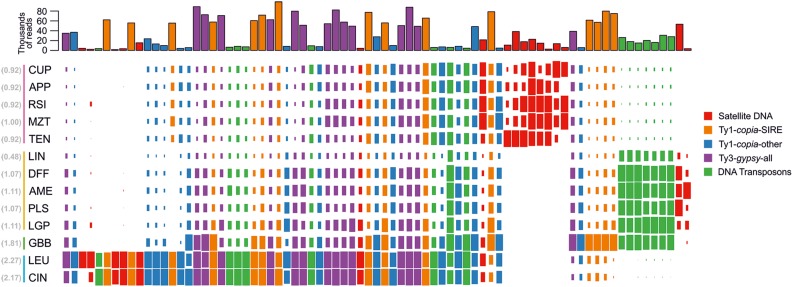
Normalized genome representation of the top clusters of five major repeat groups found in the genomes of species analyzed in the comparative analysis. Each of the four major repeat types (Ty1-copia-SIRE; Ty1-copia-others; Ty3-gypsy-all and DNA transposon) is represented by 15 top clusters whereas satellite DNA is represented by all 17 clusters. The repeats are hierarchically clustered along the horizontal axis so that repeats with similar distributions across species are grouped together. Genome size (1C value) for each species is indicated next to species name abbreviation (in brackets, gray) and the color vertical lines to the left of the species names indicate the taxonomic series the species belong to (series Cupulata, pink; series Glabribracteata, green; series Leucantha, blue; series Melampodium, yellow).